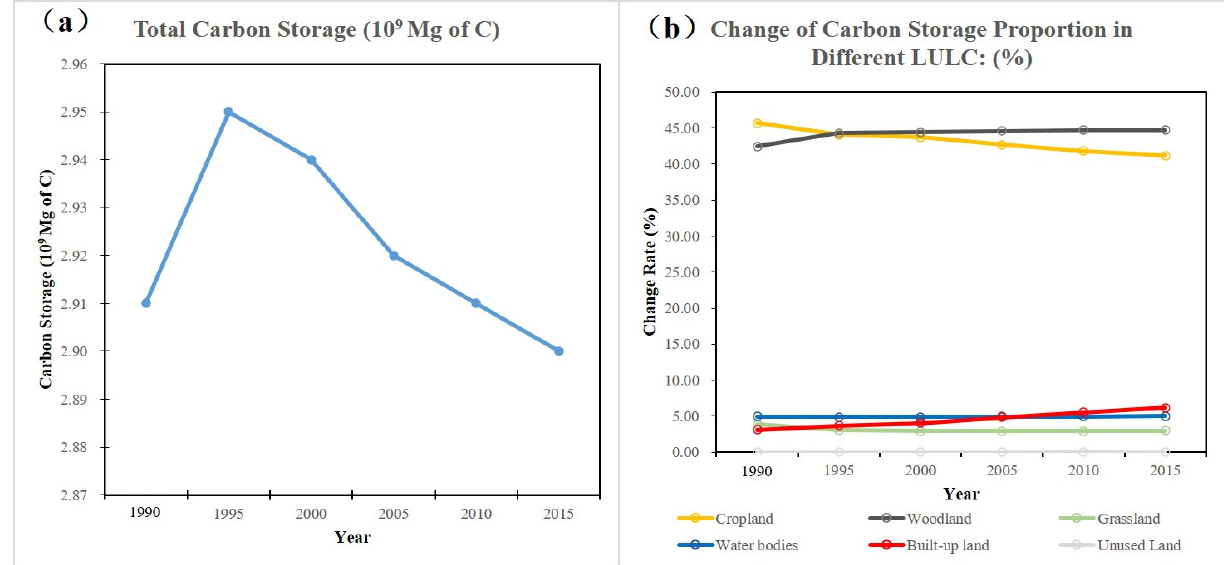
Figure 3. Dynamics and change of proportion of carbon storage of Yangtze River Delta Region (2015). ( a ) Dynamics of carbon storage of Yangtze River Delta Region (2015); ( b ) change proportion of carbon storage in LULC of Yangtze River Delta Region (2015).